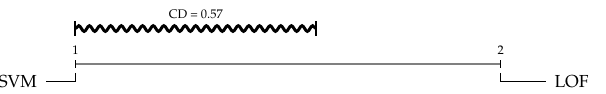
Figure 6. Critical Difference chart of F1-Score performance between LOF and OCSVM across all attack patterns and magnitudes ( (cid:101) ). It is possible to observe that there is no link between the first and second techniques, which demonstrates significant difference between OCSVM and LOF, with OCSVM as the superior one.